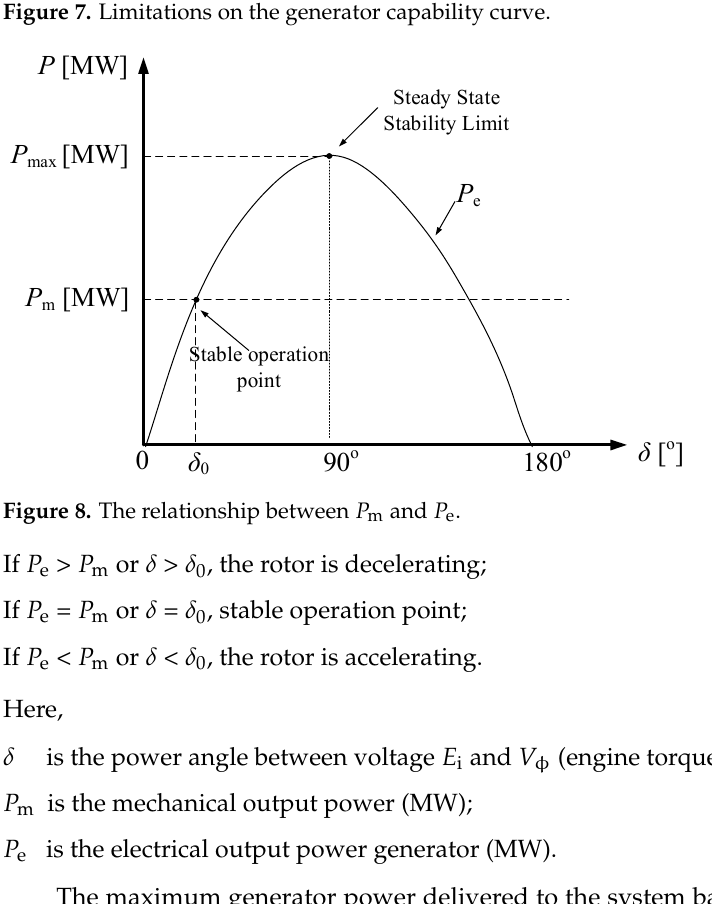
Figure 7. Limitations on the generator capability curve.